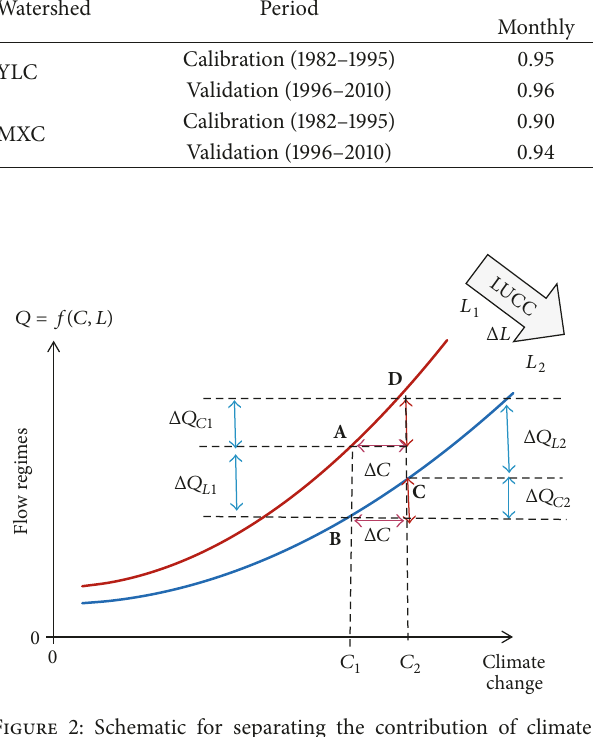
Figure 2: Schematic for separating the contribution of climate change and LUCC to flow